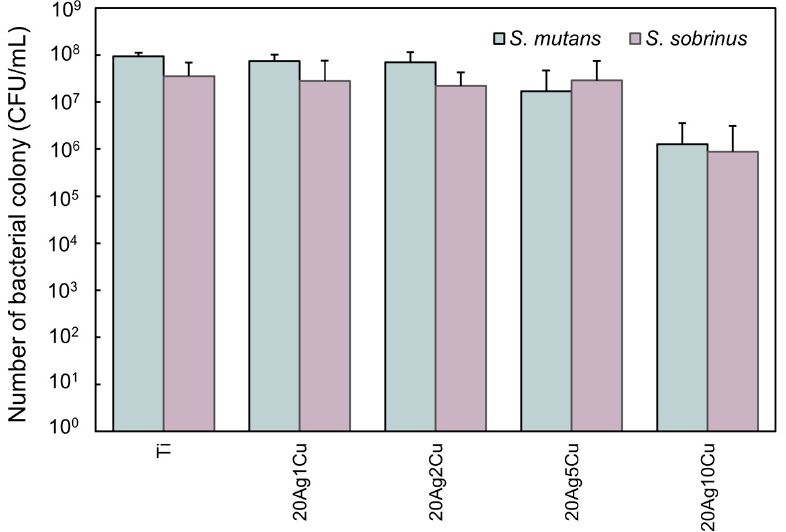
Figure 10. Viable count after direct contact with the metals.